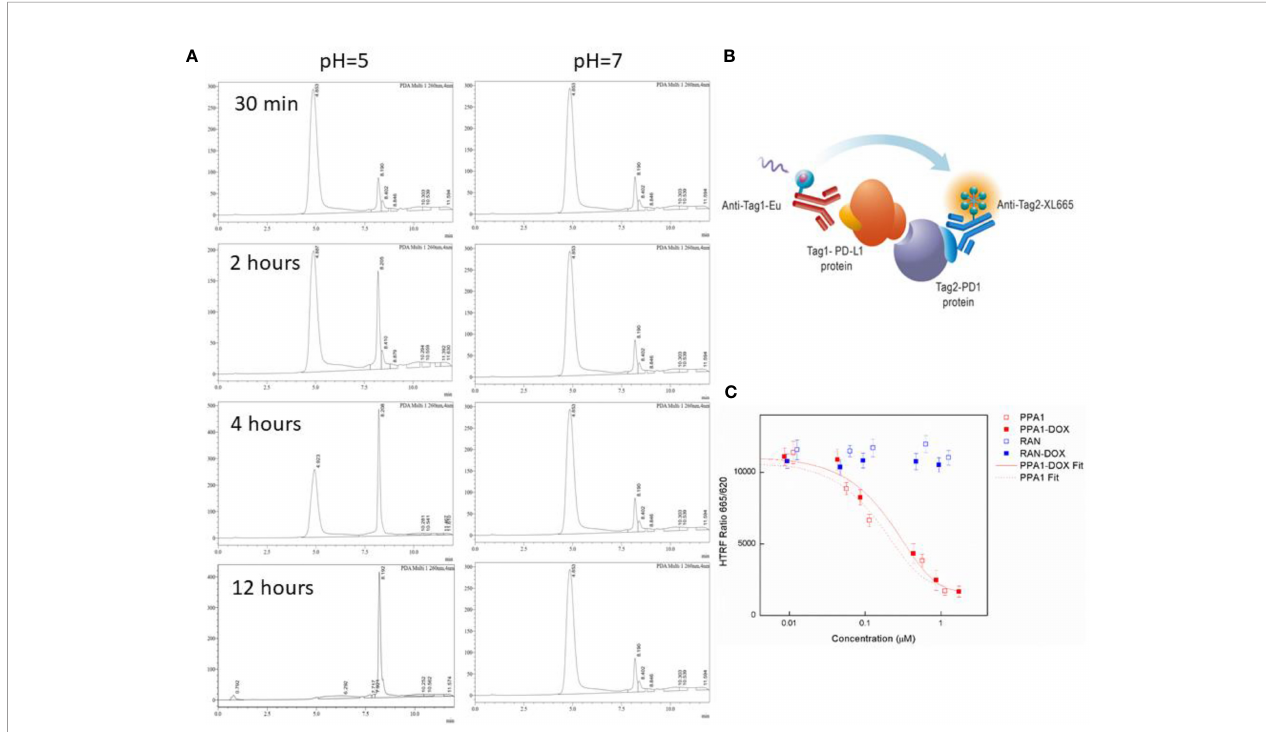
FIGURE 3 | The cleavage and binding af fi nity of the PPA1-DOX conjugate. (A) Representative HPLC chromatograms of PPA1-DOX in mouse serum (pH = 7.4) upon time. Representative HPLC chromaograms of PPA1-DOX and free DOX in the weak-acid PBS buffer (pH = 5) upon time. (B) The mechanism of HTRF assay to test the blocking of PD-1 and PD-L1. (C) The result of HTRF assay of 4 kinds of drugs. Error bars indicate mean± standard deviation. n =